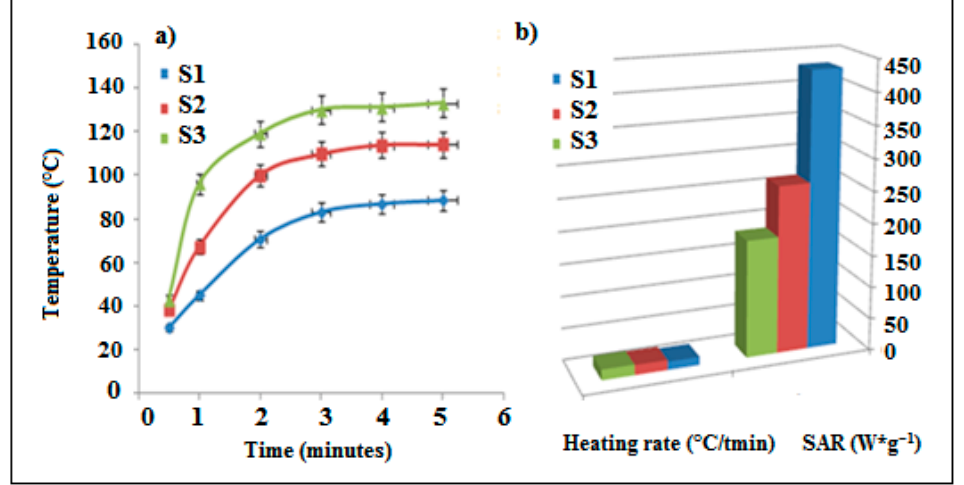
Figure 1. ( a ) Heating properties and ( b ) SAR (W*g − 1 ) and heating rate (°C/min) of samples, S1 (PDMS composite with 5 wt % of Fe), S2 (PDMS composite with 10 wt % of Fe) and S3 (PDMS composite with 15 wt % of Fe).